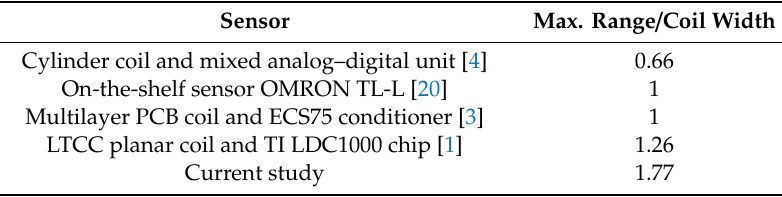
Table 2. Comparing the proximity range of the developed sensor with the sensors in referred works.